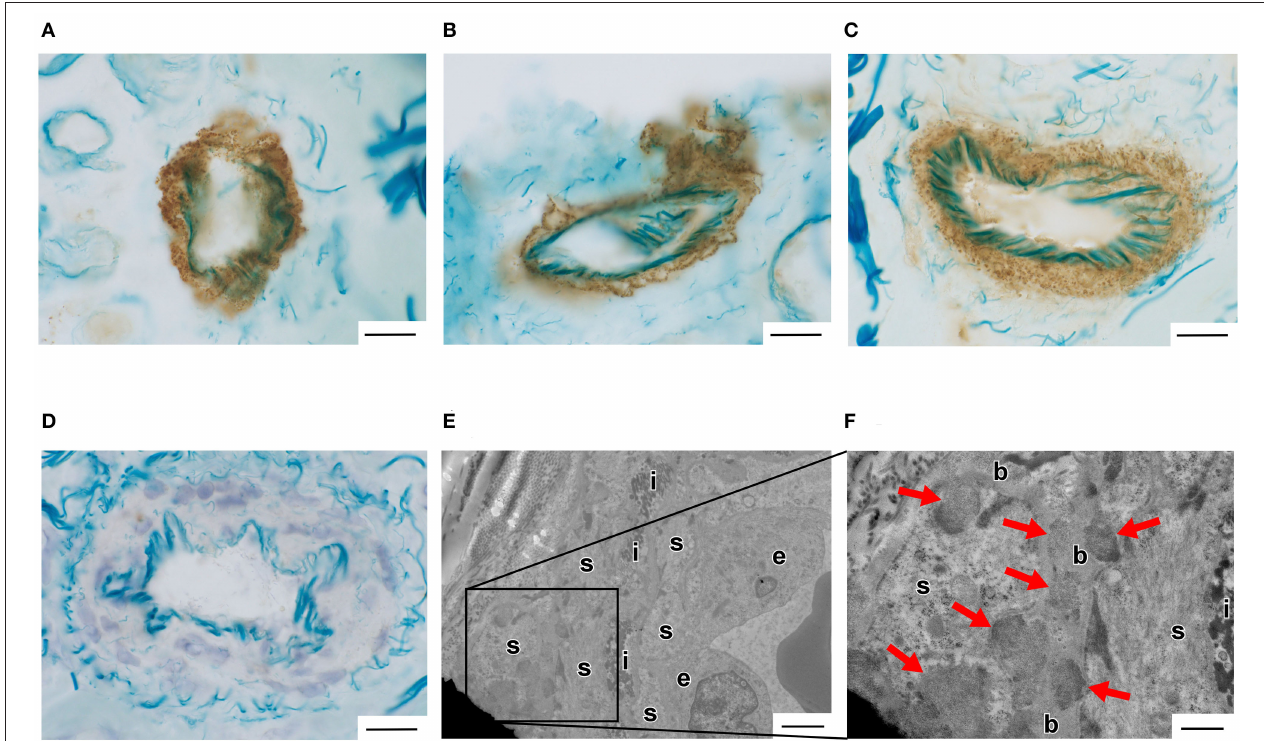
FIGURE 1 | (A–D) Vascular Notch3 ECD deposits were detected by immunohistochemical staining using anti-Notch3 ECD antibodies in an unfixed frozen skin biopsy sample obtained from a patient with cerebral autosomal dominant arteriopathy with subcortical infarcts and leukoencephalopathy (CADASIL). (A) Case 2 with the pathogenic NOTCH3 p.Arg110Cys variant. (B) Case 6 with the pathogenic NOTCH3 p.Trp1003Cys variant. (C) Case 9 with the pathogenic NOTCH3 p.Tyr1021Cys variant. (D) Case 35 with the likely benign variants of NOTCH3 p.Arg75Gln ( Table 1 ). Bars = 20 µ m. (E,F) Vascular granular osmiophilic material (GOM) deposits were detected by electron microscopic analysis in a biopsied skin sample obtained from a patient with CADASIL (Case 9 with the pathogenic NOTCH3 p.Tyr1021Cys variant, Table 1 ). Arrows indicate GOM deposits. e, endothelial cells; s, smooth muscle cells; i, internal elastic lamina; b, basal lamina. (E) Bar = 2 µ m. (F) Bar =